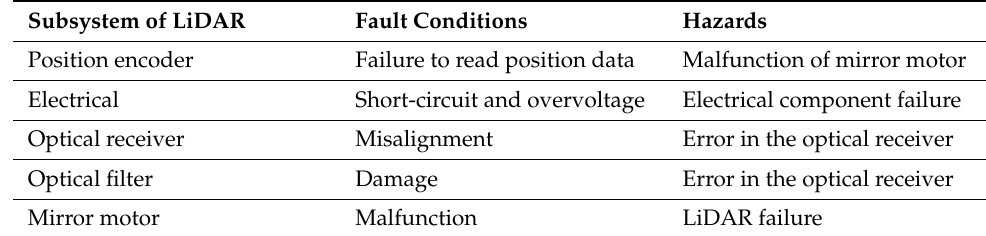
Figure 7. Demonstration of LiDAR application in a real environment for an autonomous vehicle (AV). The mapping of various object is identified (blue color represents the plane up to a certain extent; red color represents a static object; green color indicates a moving object) [62]. Table 3. Possible faults of light detection and ranging (LiDAR) sensor and their impact [14].